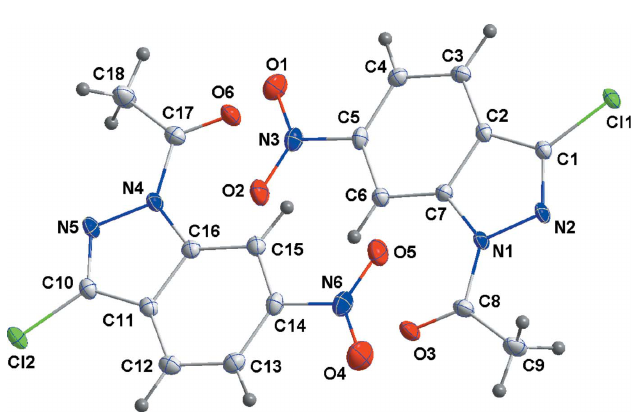
Figure 1 The asymmetric unit of the title compound, with the atom-labelling scheme and 50% probability ellipsoids.